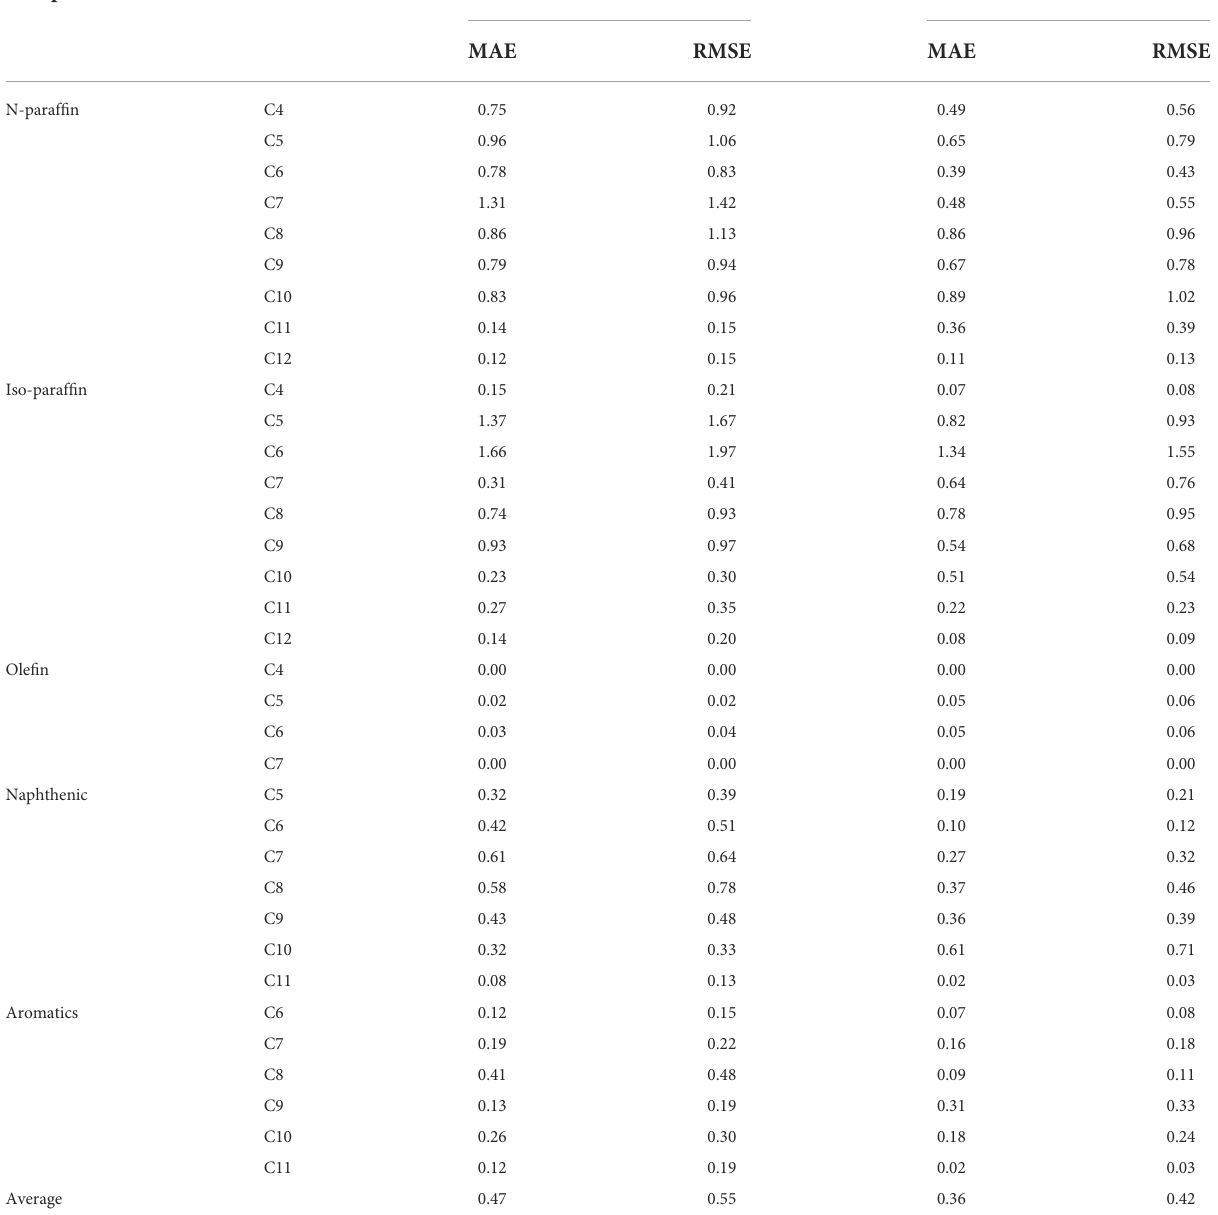
TABLE 3 Statistics on the performance of the 35 component contents of the direct and indirect ANN.